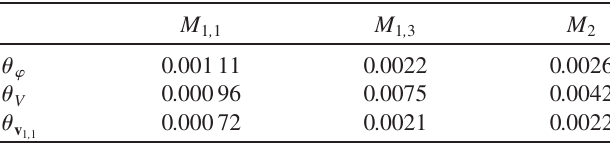
TABLE III. The rf tolerances in the working point.